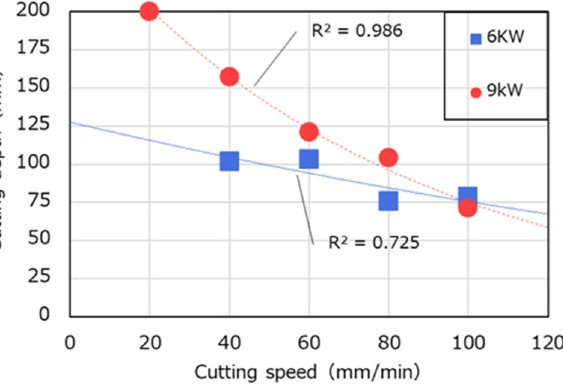
Figure 4. Relationship between the cutting speed and cutting depth for the two laser powers (compressive strength 130 N/mm 2 ).